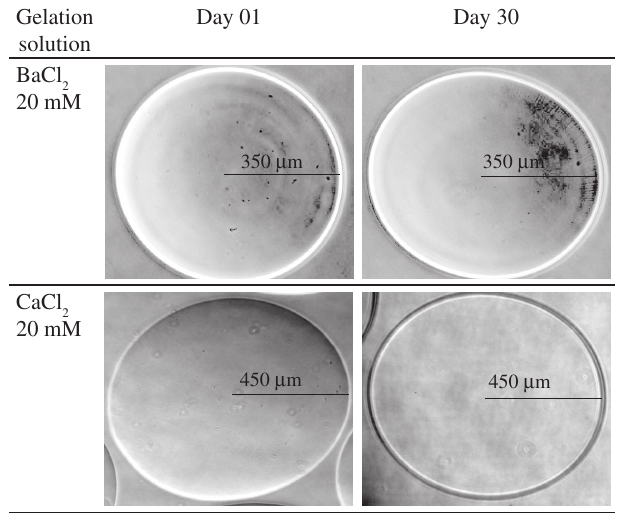
Figure 1. Comparative evaluation under phase contrast microscopy of empty microcapsules produced with Biodritin ® in different gelation solutions (20 mM CaCl or 20 mM BaCl ) after thirty days in 2 2